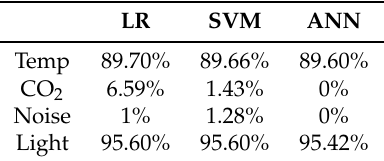
Table 3. F-Score results of applying ML algorithms to the data collected for the binary problem with default parameters.